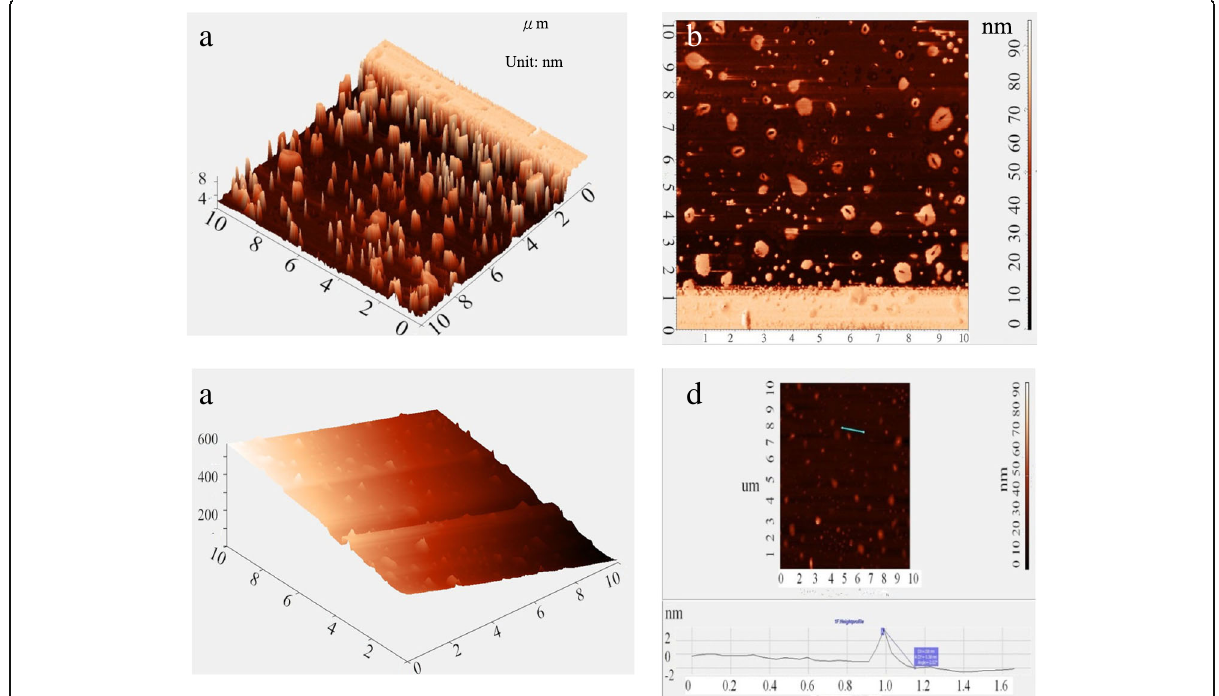
Fig. 2 AFM images of phosphorene ( a ) 3D view of phosphorene, ( b ) exfoliated multilayer of phosphorene sheets, ( c ) 3D view of phosphorene, ( d ) fix site